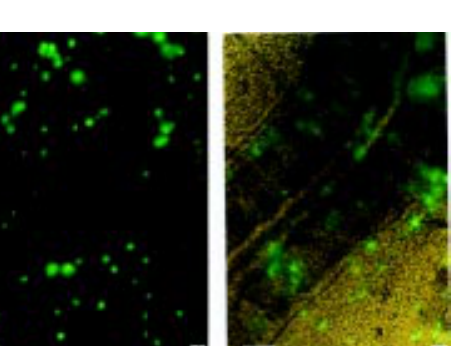
Figure 3. Embryo bombarded with 800 psi helium pressure and 500 mmHg vacuum. Medial embryo region, showing neural tube, somites and extra-embry- onic tissue. UV light (A) and over- print of UV and visible light im- ages (B). Green points indicate cells expressing green fluores- cent protein. Scale bar = 100